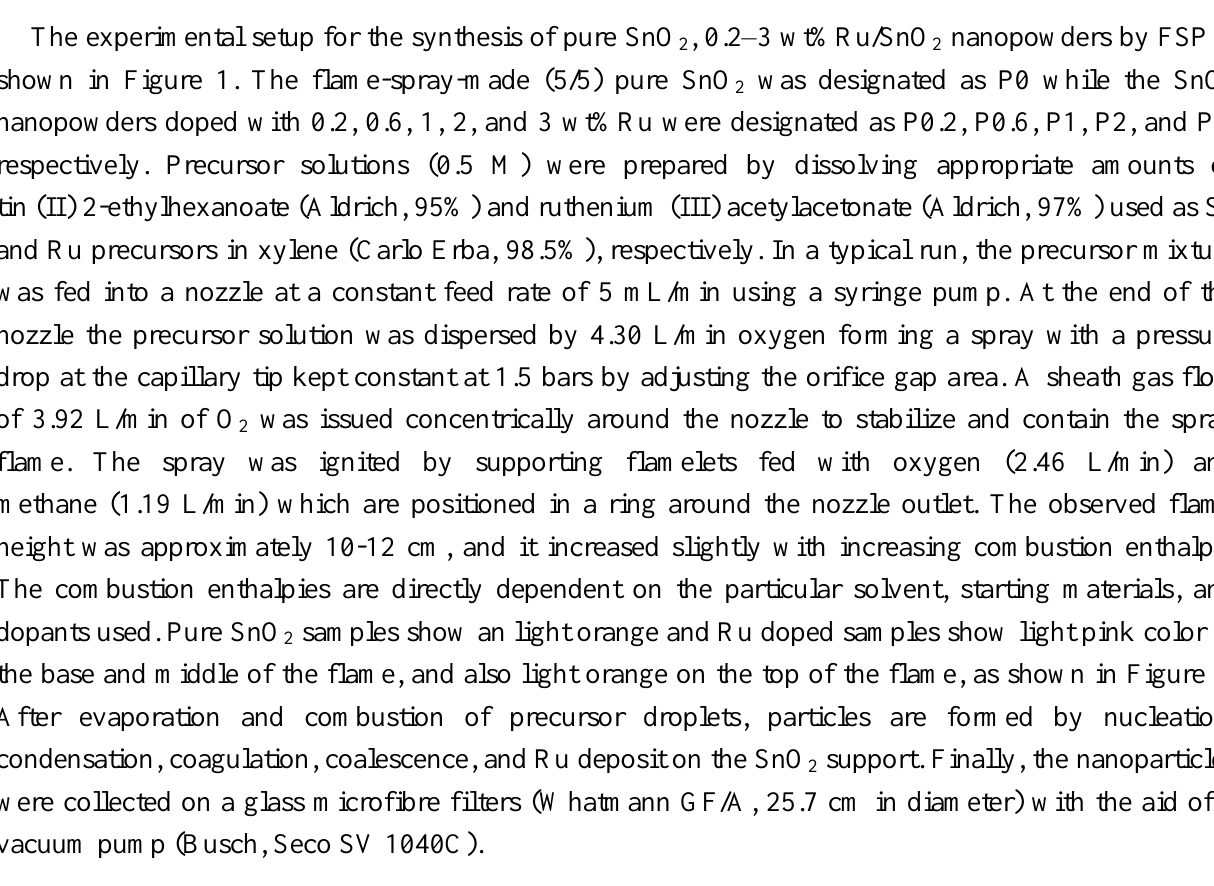
Figure 1. Schematic of the FSP experimental set up for the synthesis of samples